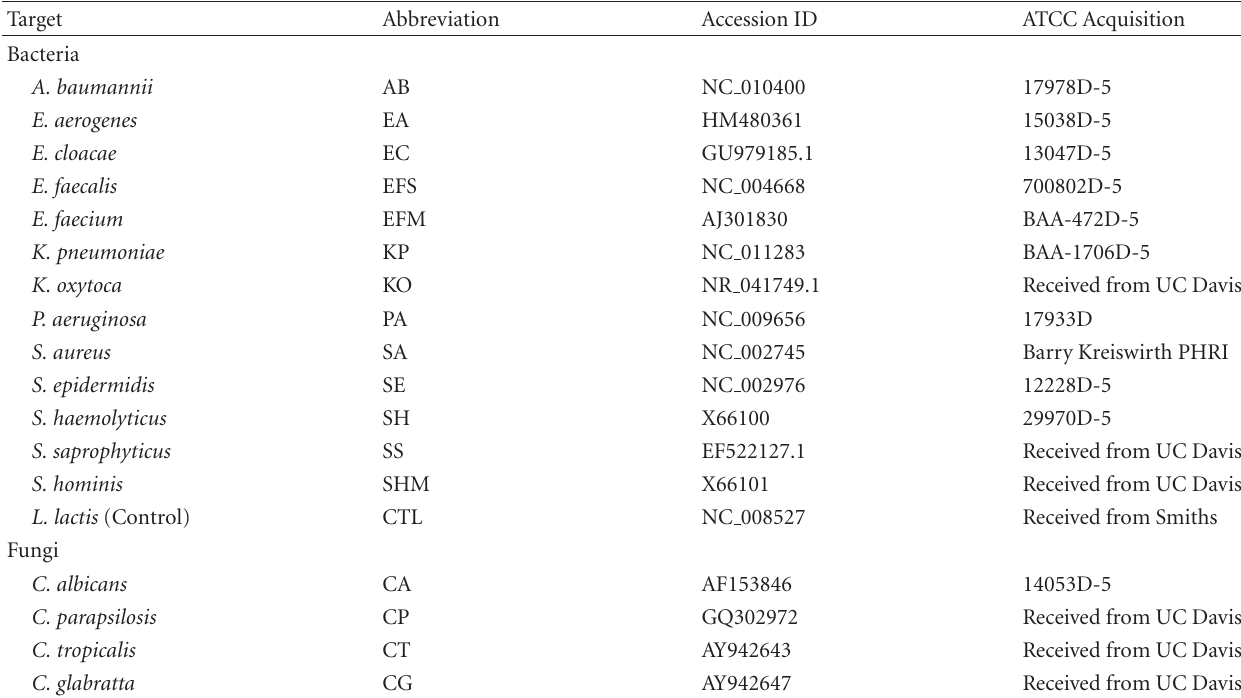
Table 4: Bacterial and fungal genomic DNA targets for 16S sepsis multiplex assay.